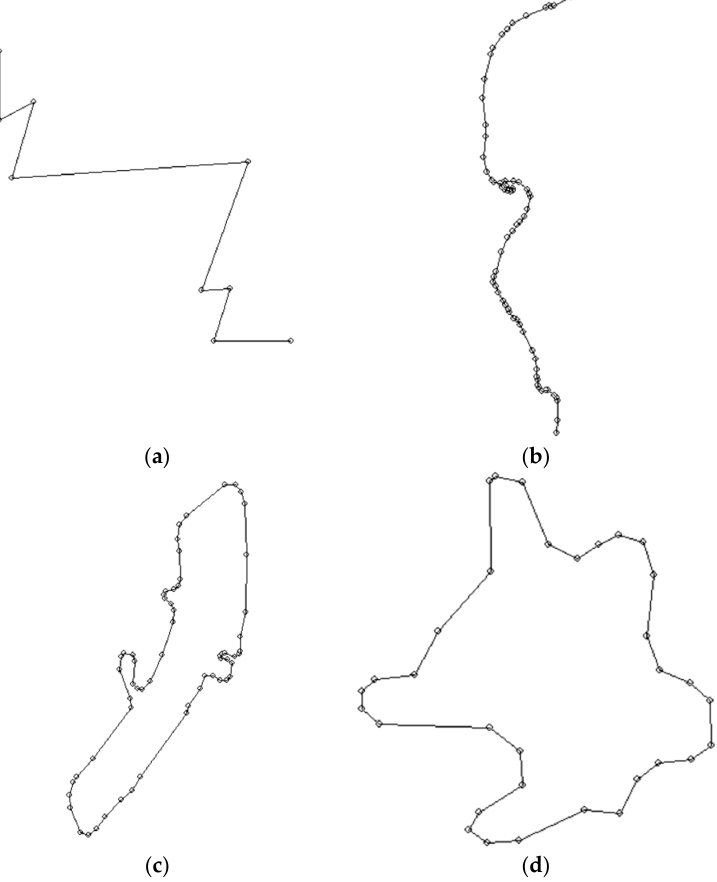
Figure 10. ( a ) Reduction of diagram data (org. Figure 6a), reduction parameter—90 m, number of vertices—9; ( b ) Line string reduction (org. Figure 6c), reduction parameter—2.1 m, number of vertices—81; ( c ) Polygon reduction (org. Figure 7a), reduction parameter—2.5 m, number of vertices—62; ( d ) Polygon reduction (org. Figure 8a), reduction parameter—4.1 m, number of vertices—34.